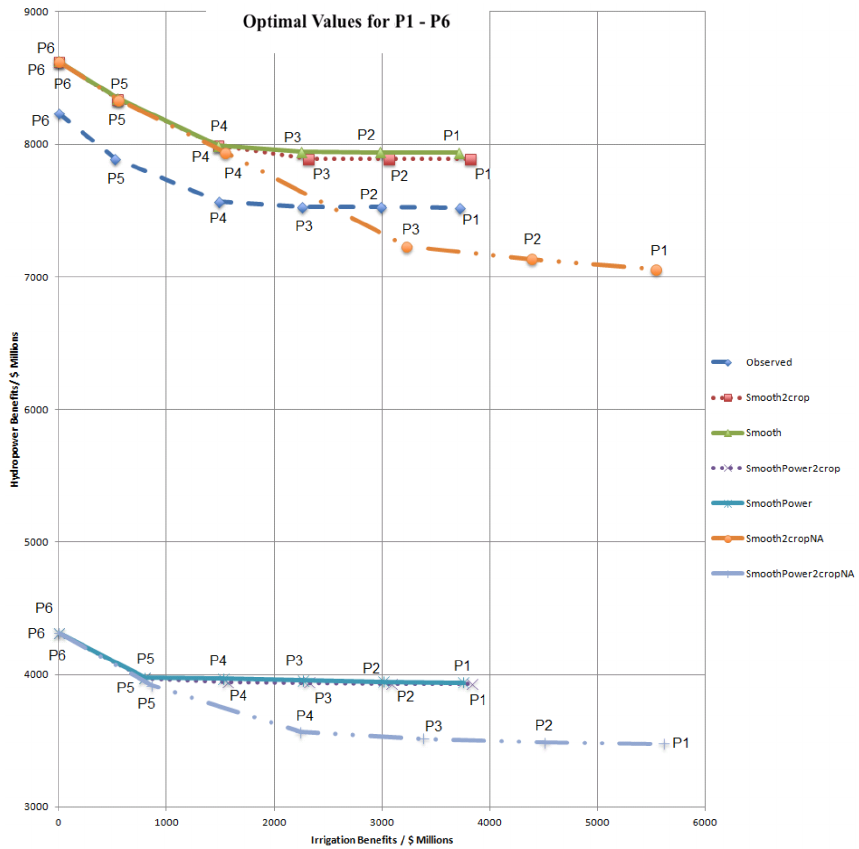
Figure 9. Hydropower vs. irrigation benefits illustrating adaptive management practices. Points represent Pareto optima values for water value sets